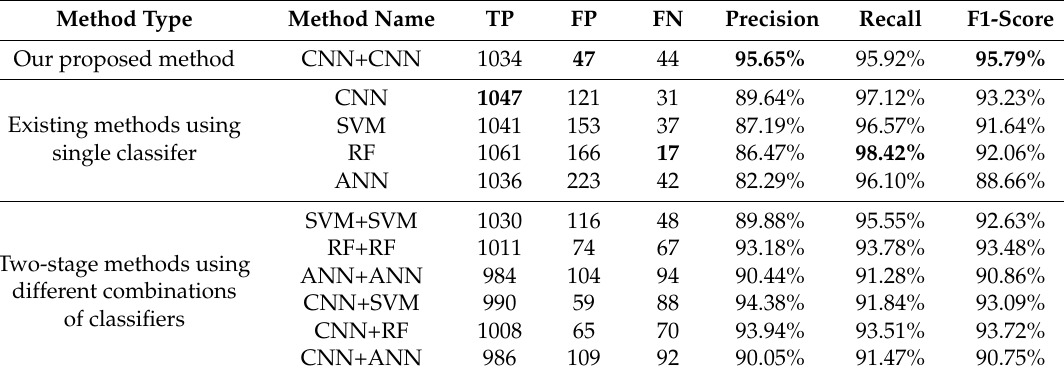
Table 4. The detection result of each method in Region